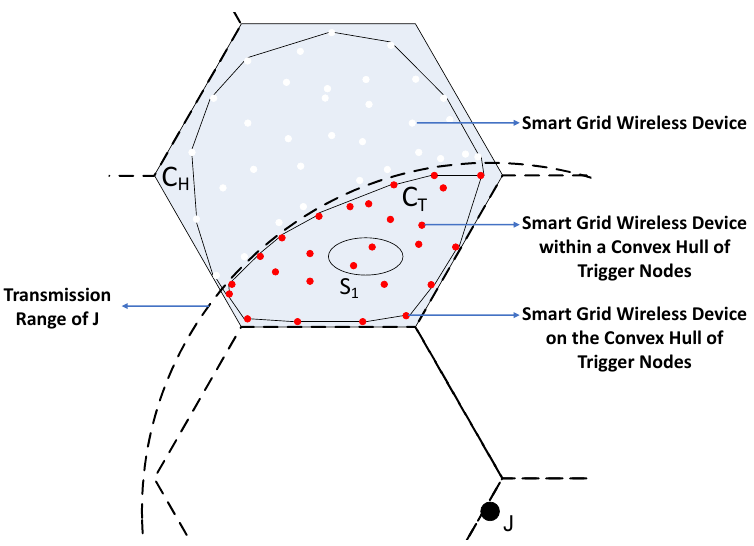
Figure 4. Trigger Nodes in a Hexagon.